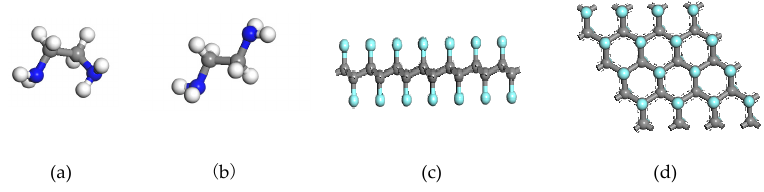
Figure 1. ( a ) Gauche-structure ethylenediamine (EDA); ( b ) trans-structure EDA; ( c ) fluorinated graphene (CF) chair structure: front view; ( d ) CF chair structure: top view. Gray, blue, white, and cyan colors represent C, N, H, and F atoms, respectively.